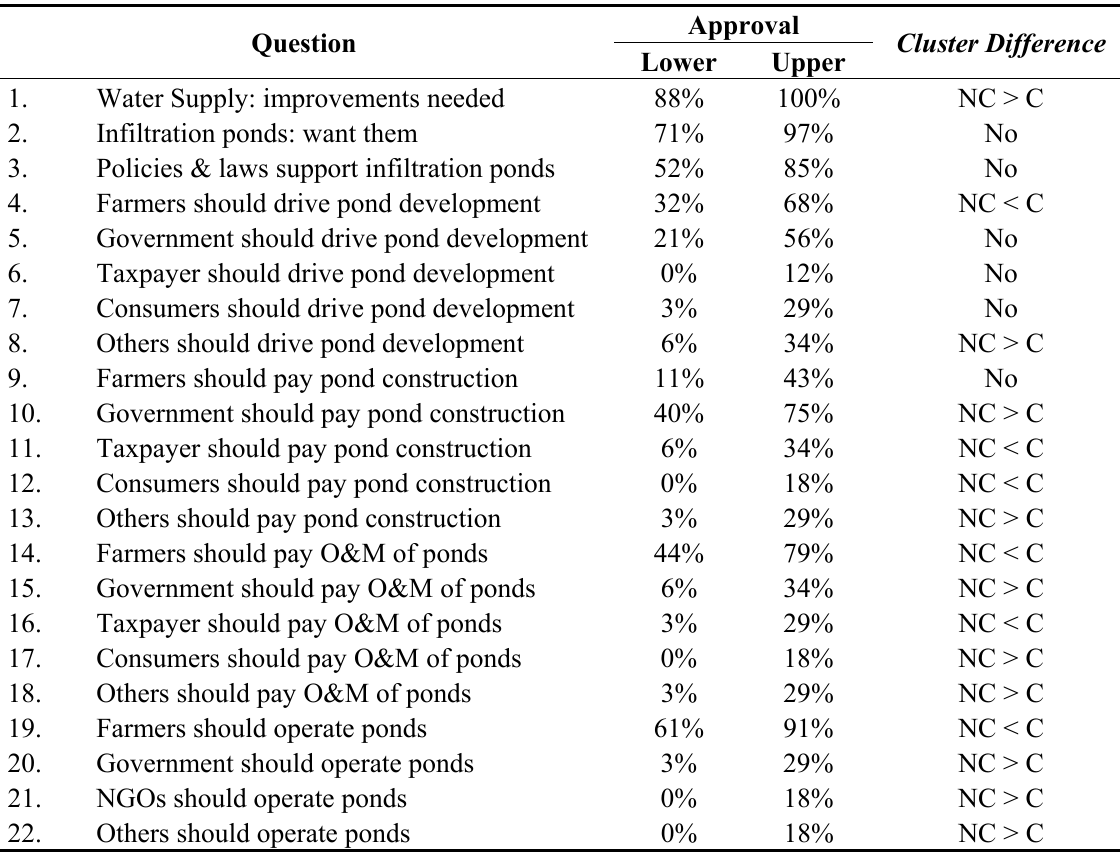
Table 4. One-sided 95% Clopper-Pearson confidence intervals for stakeholder views.